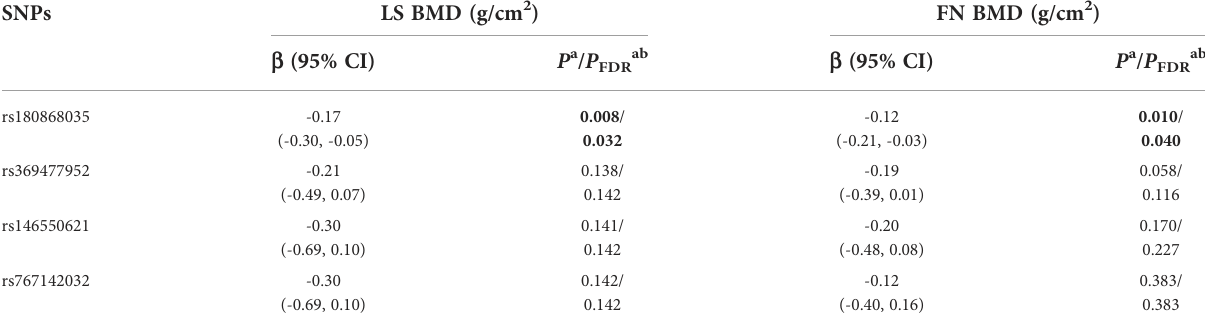
TABLE 6 Multivariate linear regression results of associations between rare genetic variants and BMDs in the combination data analysis.